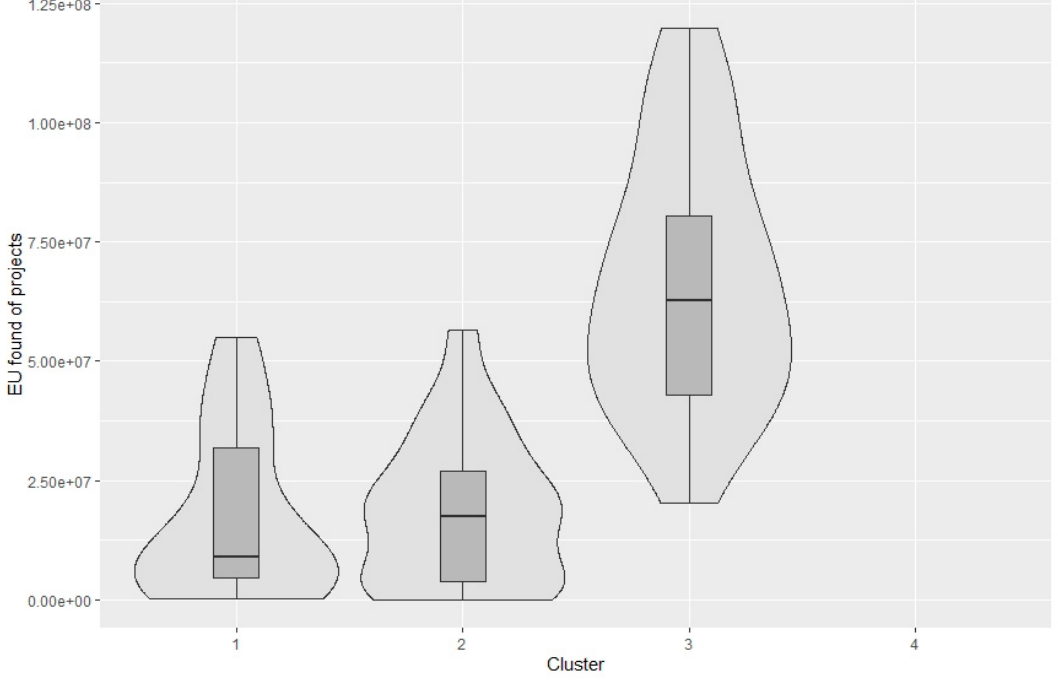
Figure A7. Violin plots for EU funds of wind projects in clusters, cluster 4–no projects.